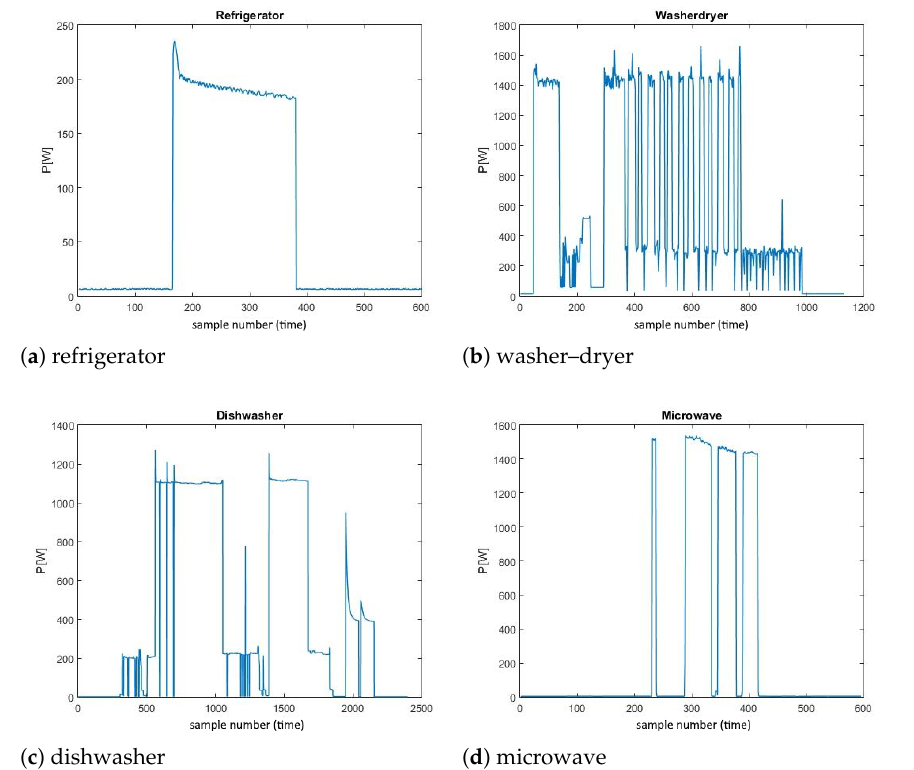
Figure 5. Examples of individual consumption measurements of the